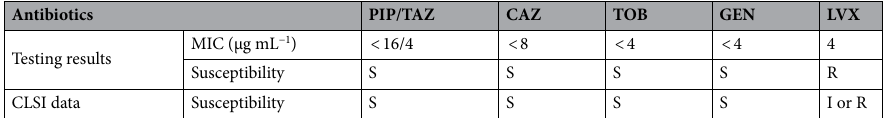
Table 2. The AST results of this protocol and CLSI data for P. aeruginosa (ATCC 27,853). S: susceptible, R: resistant, I: